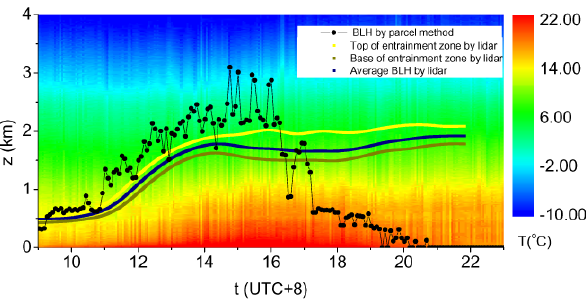
Fig. 4. Comparison between results from lidar and microwave pro- filing radiometer measurements for 29 July 2007. The dotted line represents the BLH from the microwave profiling radiometer de- termined by the parcel method and each dot is the average for five minutes